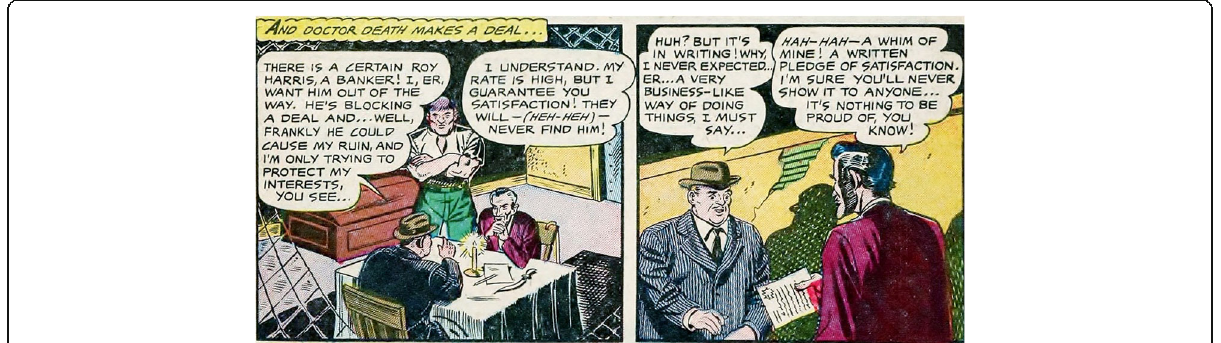
Fig. 1 Two panels from the graphic story Black Cobra (1954). In these panels, the bodily positions convey consistency with the stated goal (i.e., the client is given a contract from the hit man). Available from https://digitalcomicmuseum.com/index.php?cid=735